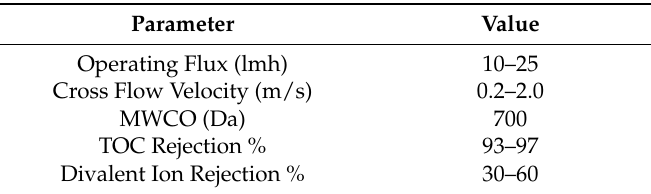
Table 1. Membrane characteristics and